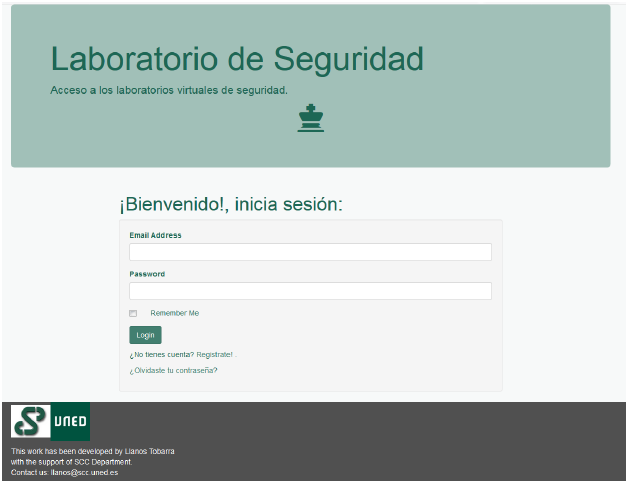
Figure 2. Virtual remote laboratory, ViRe-Lab.